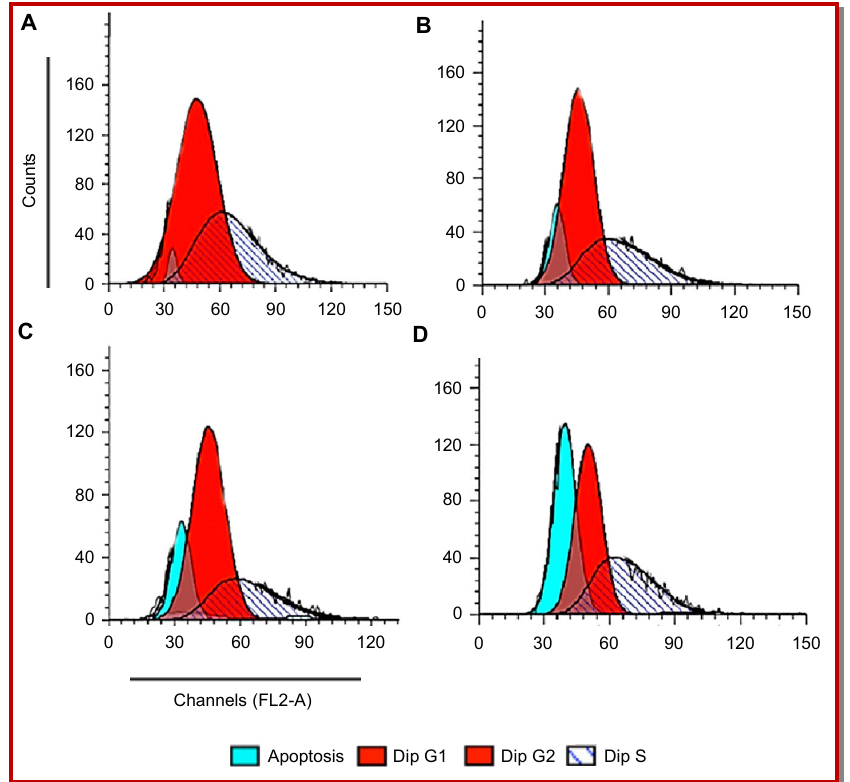
Figure 6: Effect of alantolactone pyrazoline analogue (APA) on cell cycle in NSCLC cells. The cells were subjected to 0 μ M (untreated, A), 25 μ M (B), 75 μ M (C) and 120 μ M (D) of APA. The apoptotic cells increased from A-D, with an increase in APA dose. The cell cycle distribution was determined by a flow cytometric analysis of the DNA content after staining with propidium